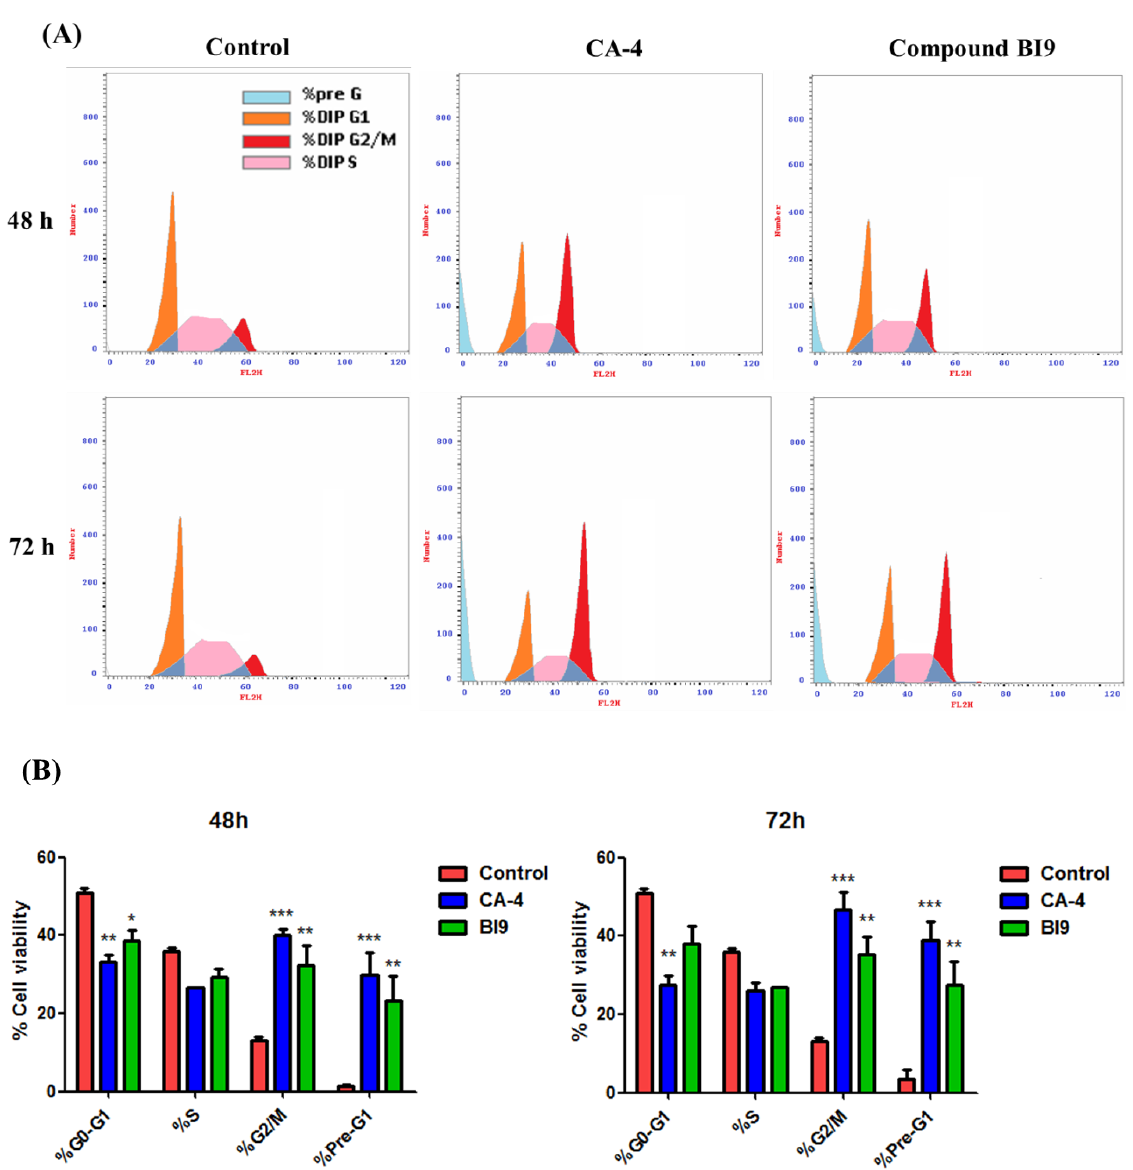
Figure 2. ( A ) Cell cycle analysis of HL-60 cells treated with compound BI9 and CA-4 for 48 and 72 h. Cells were fixed and labeled with PI and analysed by flow cytometry as described in the experimental section. ( B ) The number of cells with 4N (G2/M), 2N(G0G1), and <2N (sub-G1) DNA content was determined with CellQuest software. Data are represented as mean of two independent experiments ± SEM. The asterisk indicate statistically significant